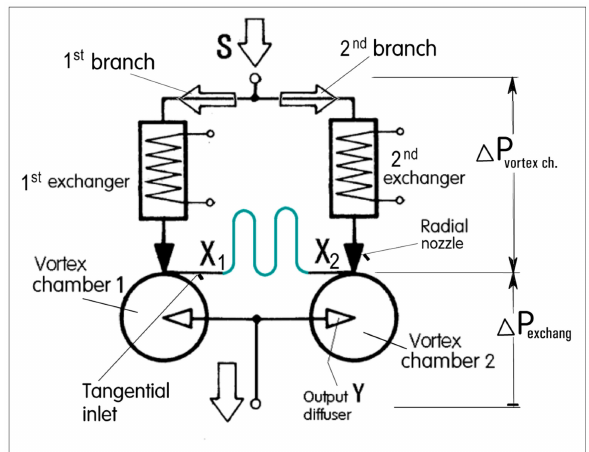
Figure 27. Oscillator based on the “flip-flop” configuration. Agitation by alternating fast and slow flows in the heat exchangers transport processes according to Reference